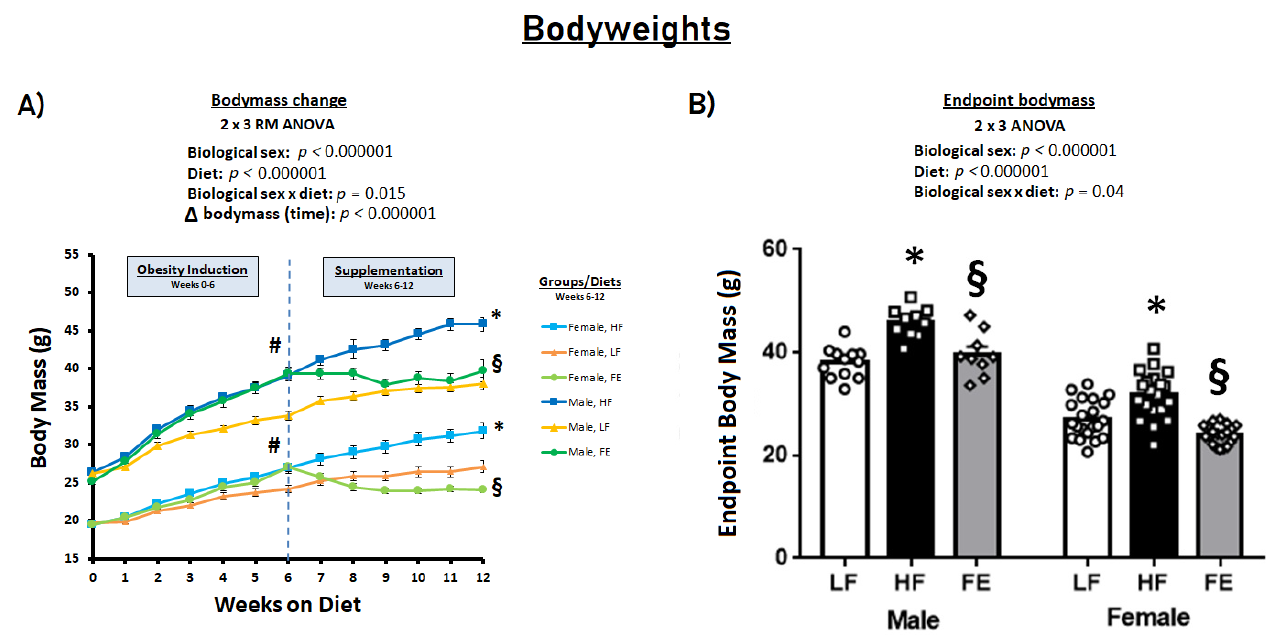
Figure 2. Effects of the ‘Fertility Enhancer’ supplement on bodyweights in Western diet-fed C57BL/6J mice. ( A ) Longitudinal changes in body mass. ( B ) Endpoint body mass. * Significantly different from LF ( p ≤ 0.05). § Significantly different from HF ( p ≤ 0.05). # Significantly different from baseline within groups. Table 1. Effects of the ‘Fertility Enhancer’ supplement on food consumption, bodyweights, body composition index, tissue weights, and blood glucose in Western diet-fed C57BL/6J mice.